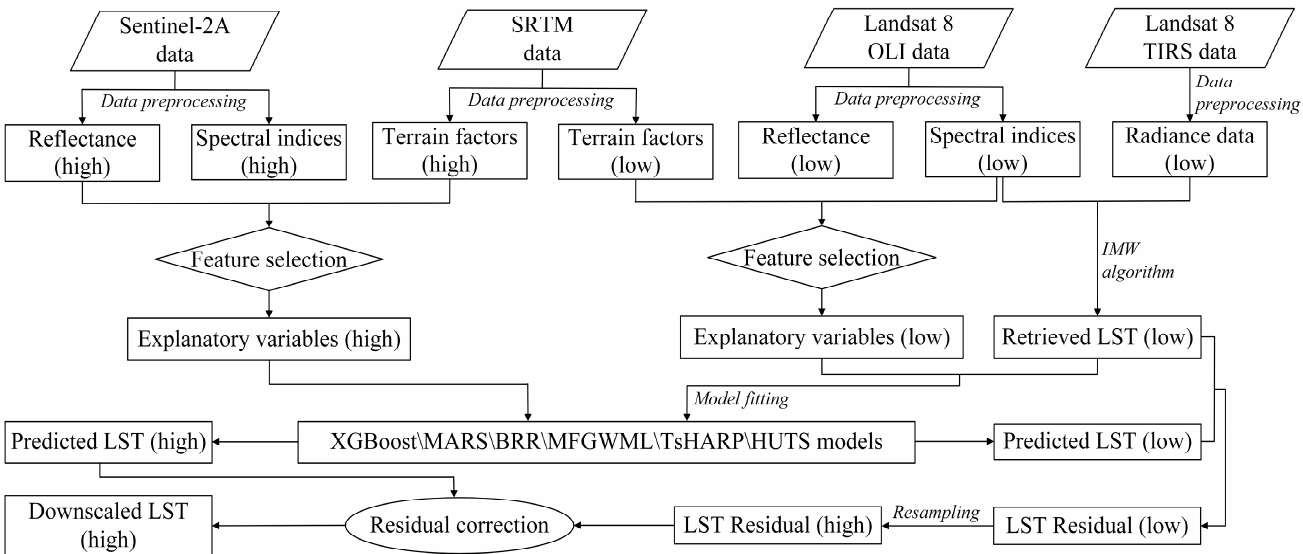
Figure 2. Flowchart of the LST downscaling procedure. IMW, improved mono-window; “(low)” and “(high)” represent coarse spatial resolution and relatively high spatial resolution, respectively.